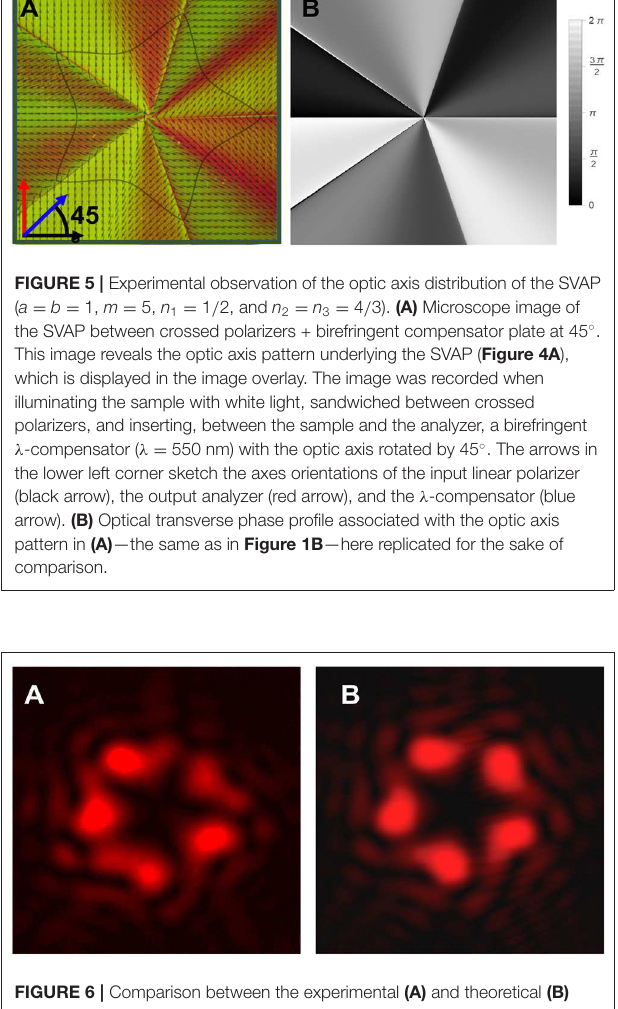
FIGURE 6 | Comparison between the experimental (A) and theoretical (B) intensity profiles of the beam generated through the SVAP with the optic axis b pattern shown in Figure 4A at distance z 1 m, for the values a 1, = = = m n 3 5, n 1 1 / 2, and n 2 4 / 3 of the curve parameters and for an input = = = = gaussian beam with a plane wavefront and radius w 0 (1.50 0.04) = ±